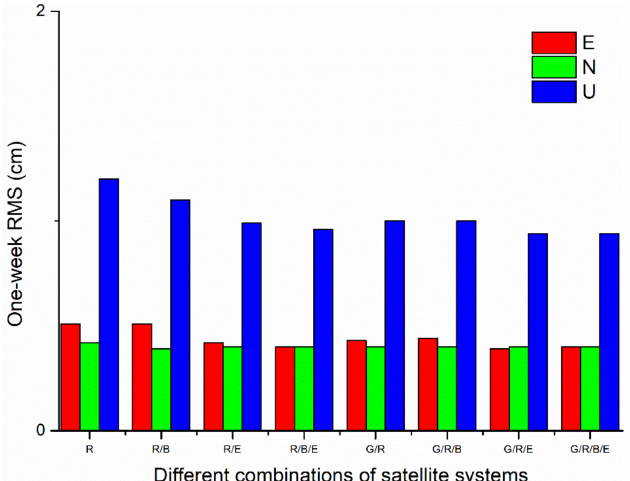
Figure 5. Positioning accuracy of different combined solutions for the QF model in static mode.